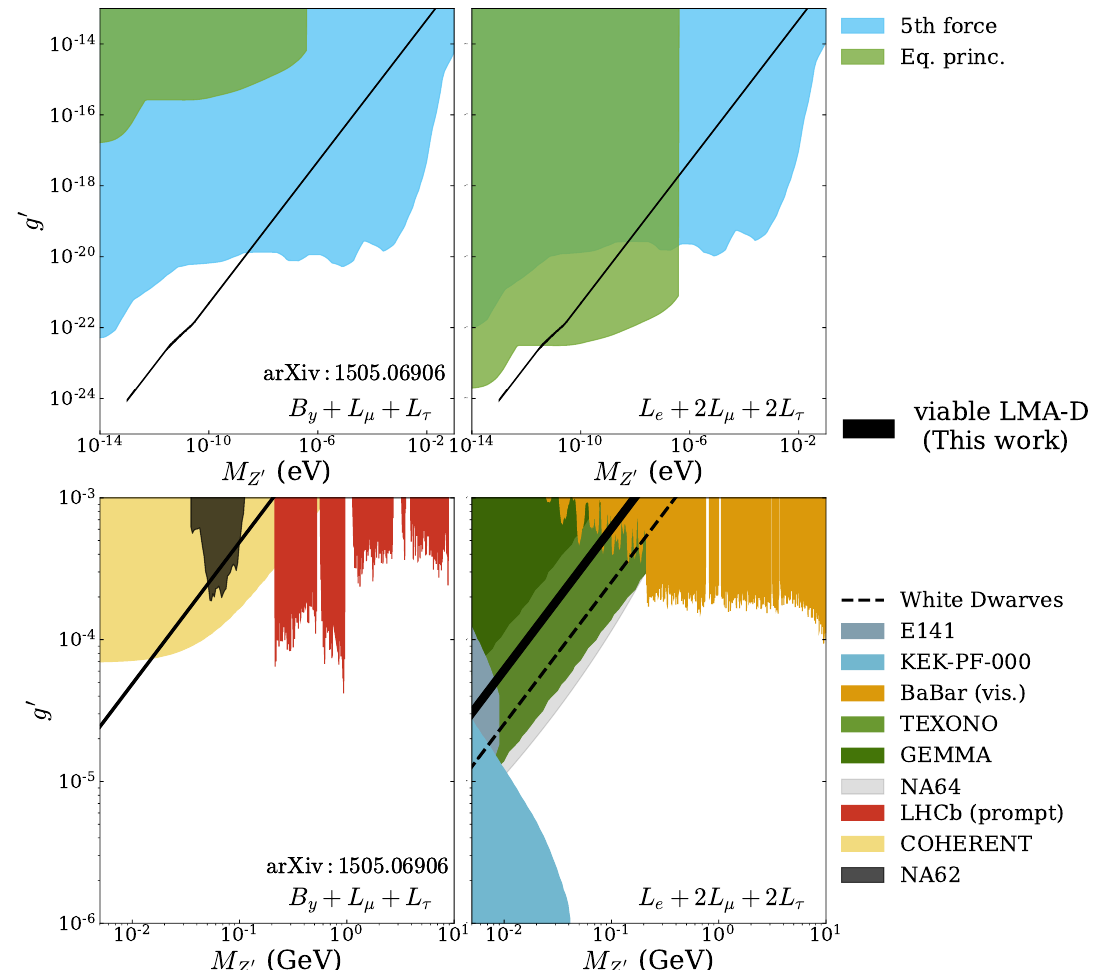
Figure 4. Range of g 0 and M Z 0 for which the global analysis of oscillation data can be consistently described within the LMA-D solution, eq. (3.7), (black band) for two viable models. We also show the bounds on these models imposed by a compilation of experiments as labeled in the figure. In the window corresponding to the model in ref. [22] we have defined B y ≡ B 1 − yB 2 − (3 − y ) B 3 . See text for